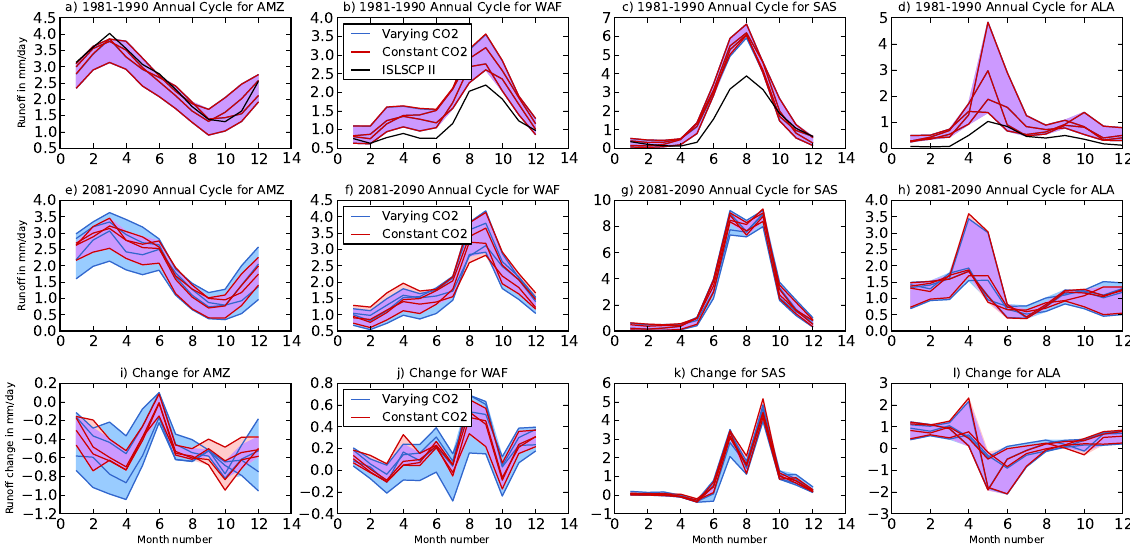
Fig. 6. Annual cycles of runoff for selected Giorgi regions using runs from models including both varying CO 2 and constant CO 2 . Lines represent each varying CO2 run and each constant CO 2 run: (a–d) : absolute values for 1981–1990, (e–h) : absolute values for 2081–2090, (i–l) : absolute changes between 1981–1990 and 2081–2090.